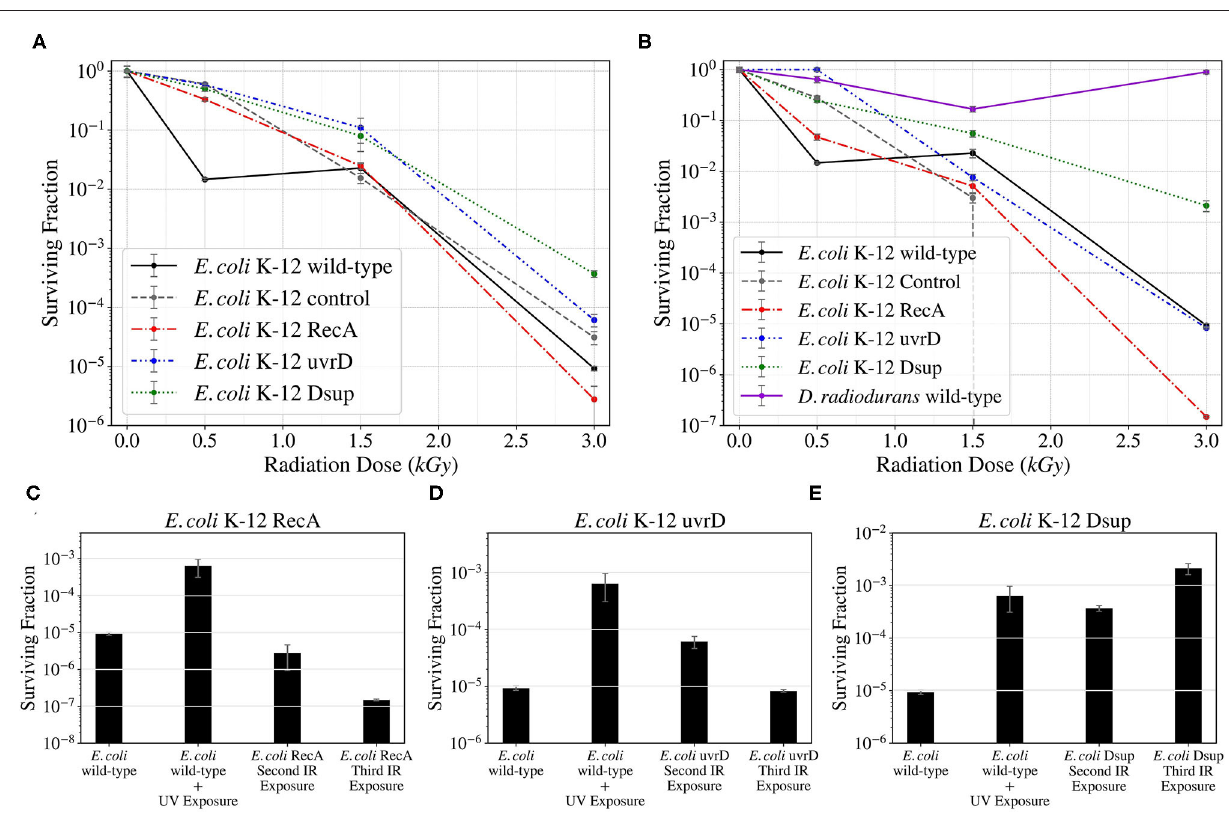
the lowest impact on preventing DNA damage, with a higher number of mutations than the other strains. From the sequencing results obtained, no relevant mutations can be seen that could